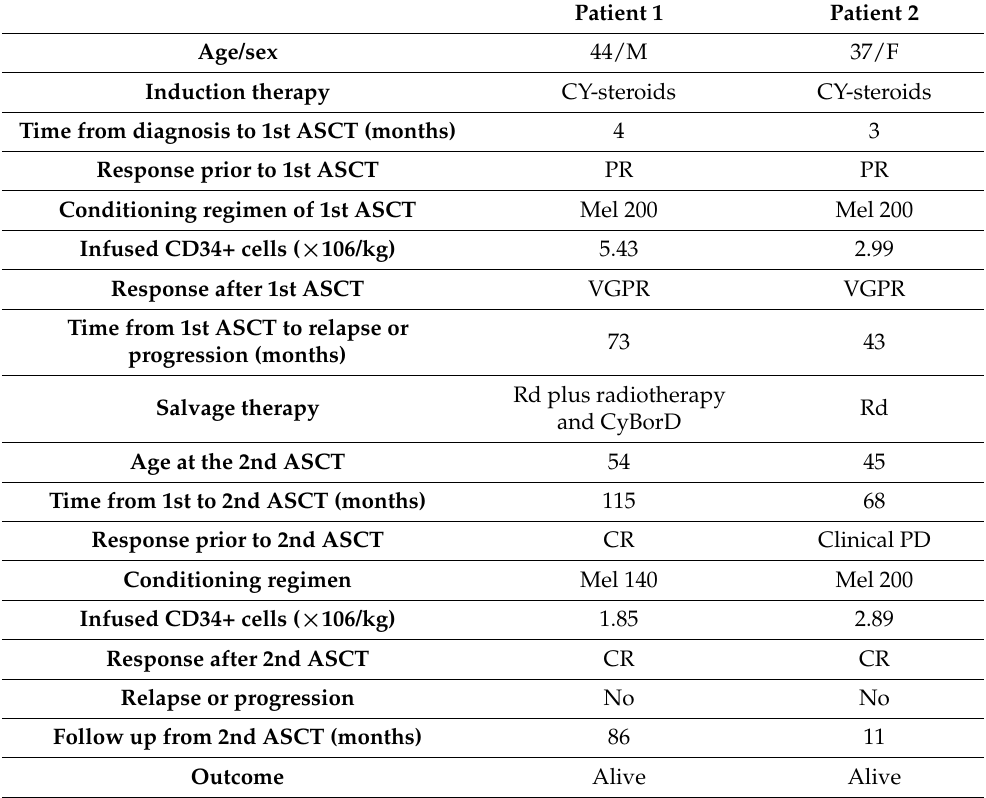
Table 1. Patients